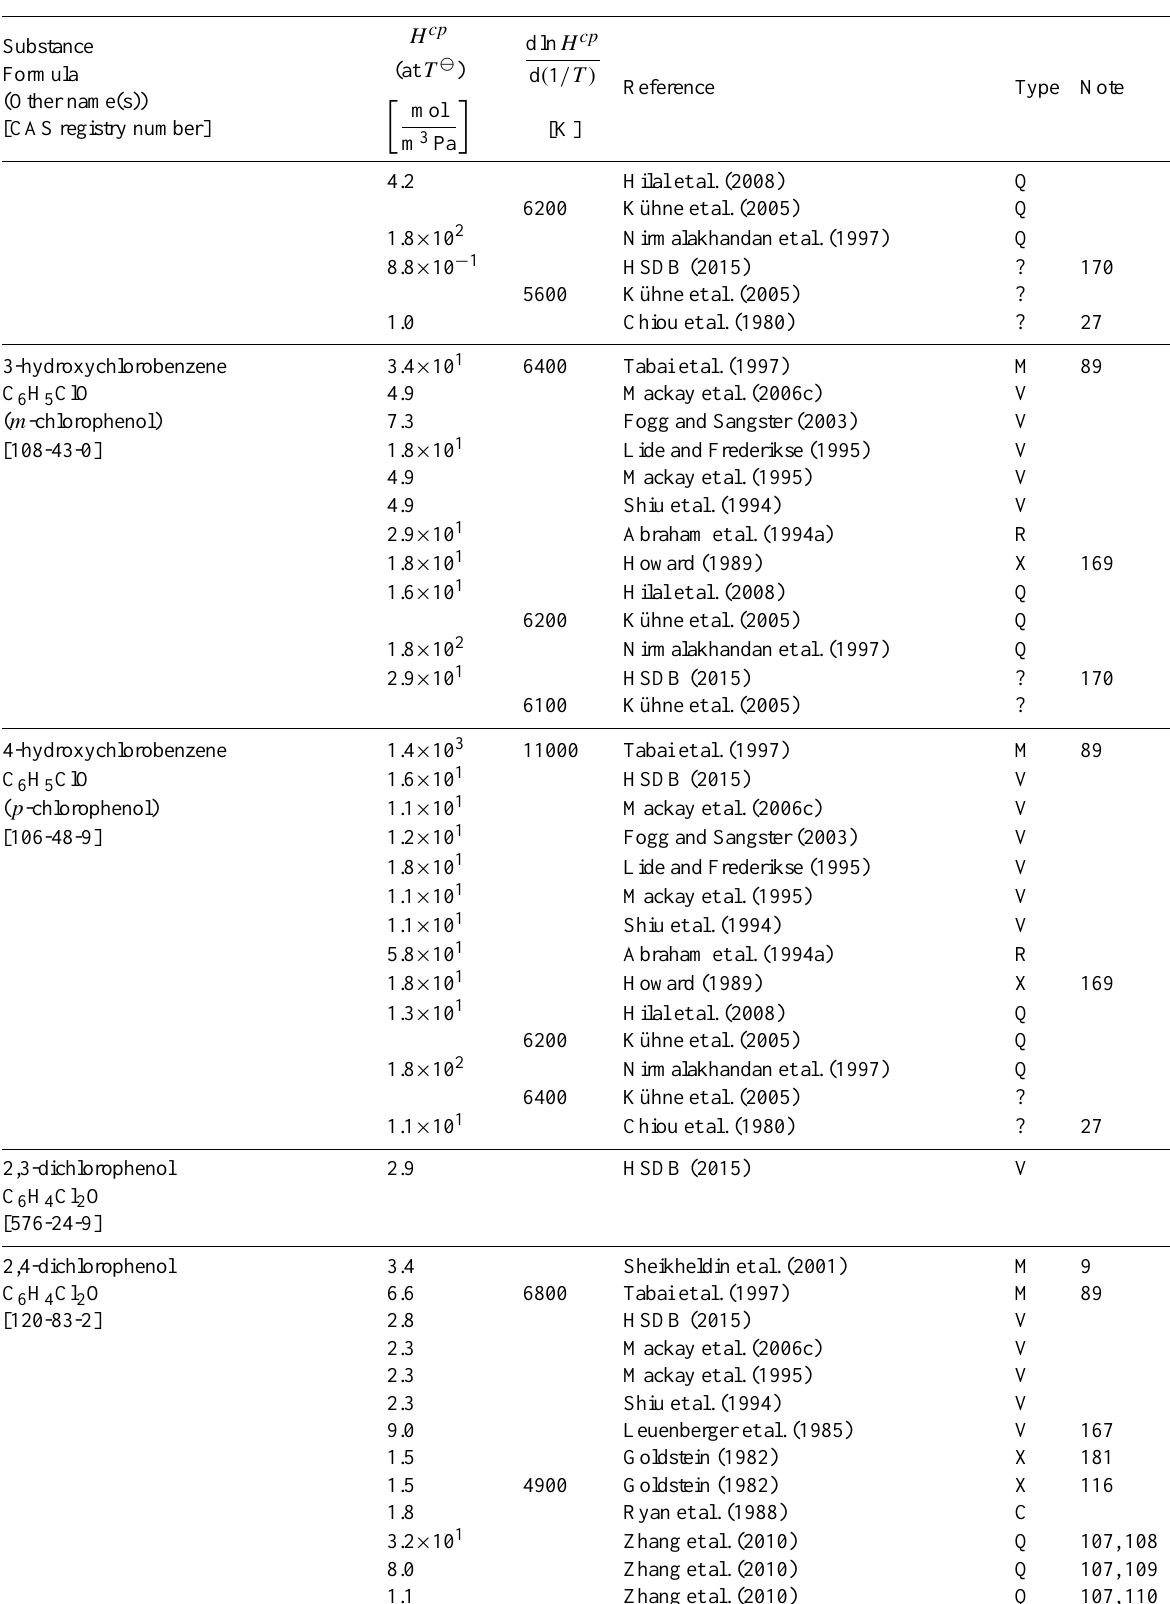
Table 6: Henry’s law constants for water as solvent